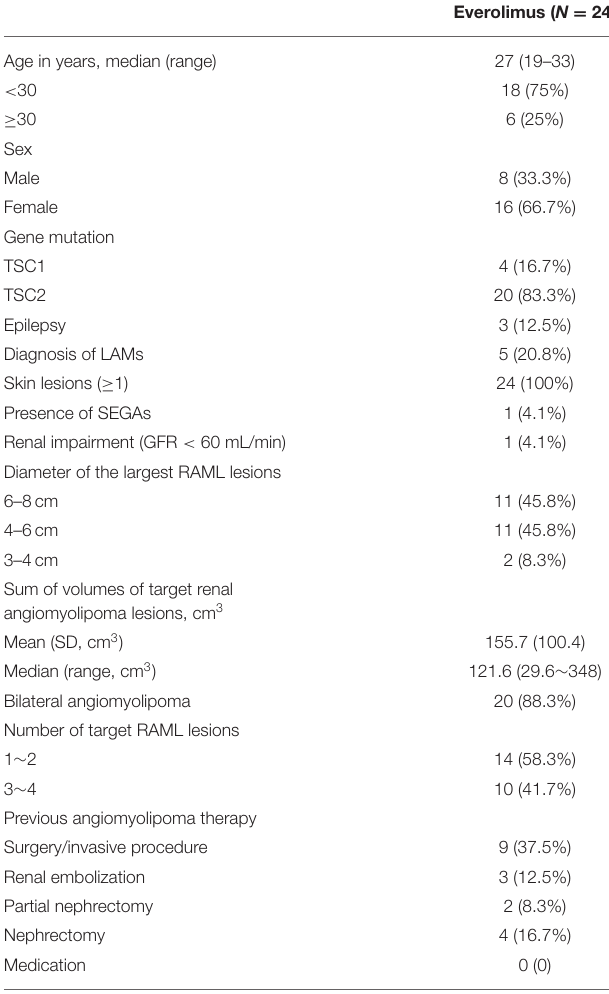
TABLE 1 | Baseline patient demographic and disease